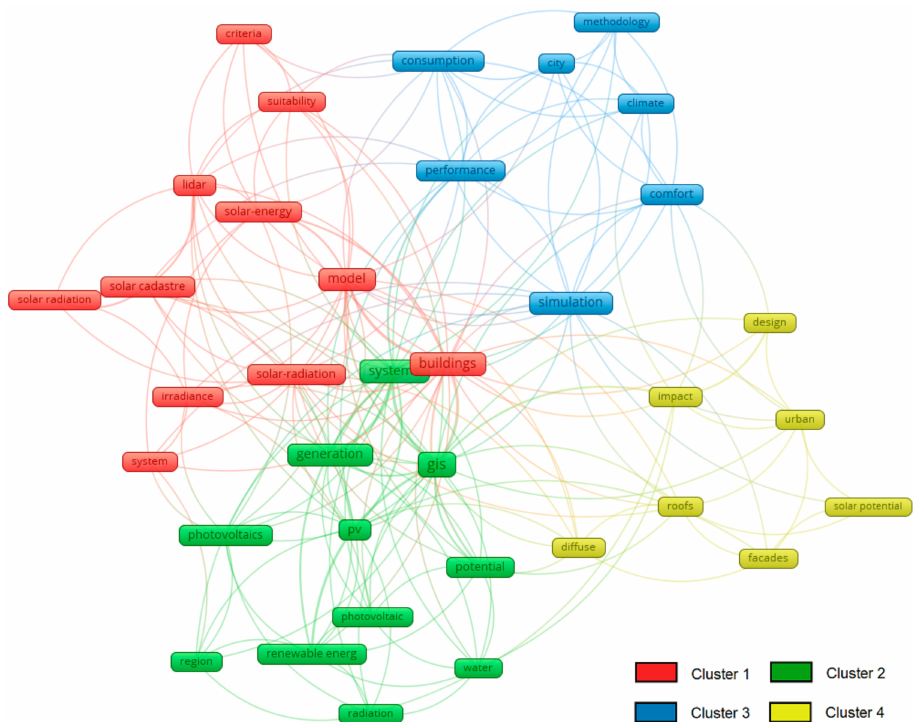
Figure 3. Keyword network from Web of Science. Source: own